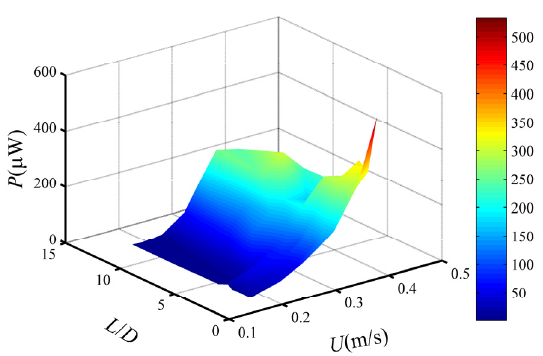
Figure 10. Relationships among the output power, the water speed and the spacing ratio.